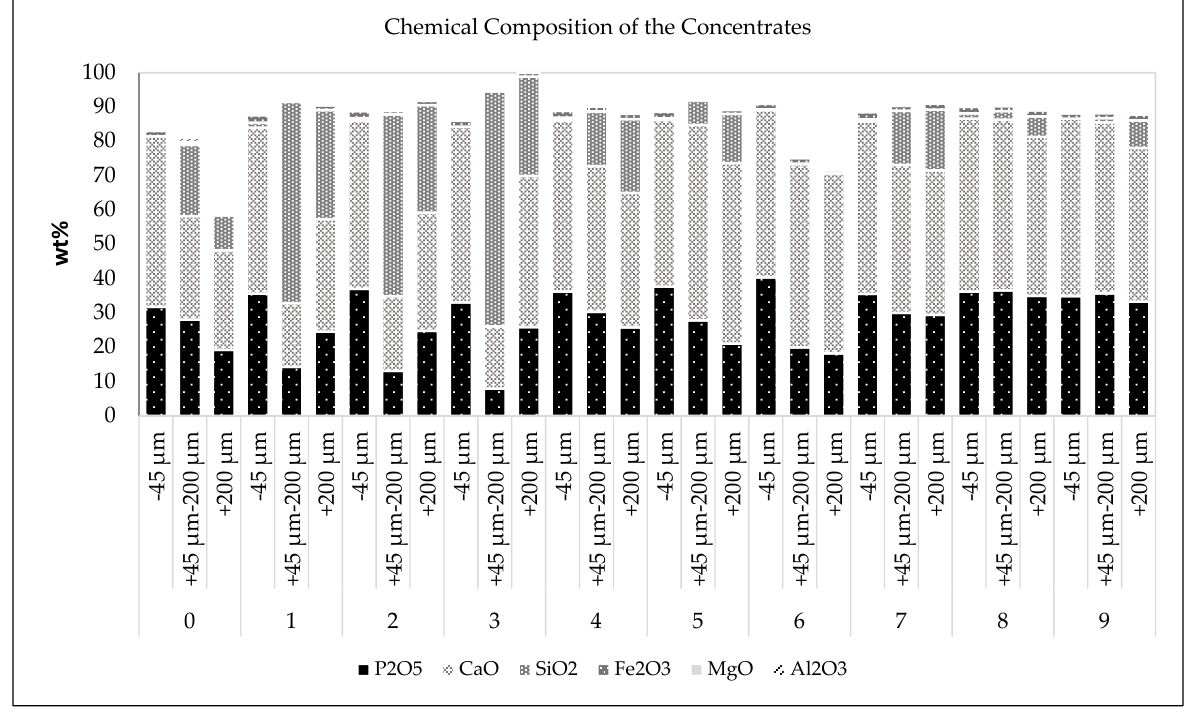
Figure 6. Chemical composition of the Concentrates for 10 conducted tests. Table 3. Mineral analysis of the representative tests 5 and 7 (NT5,